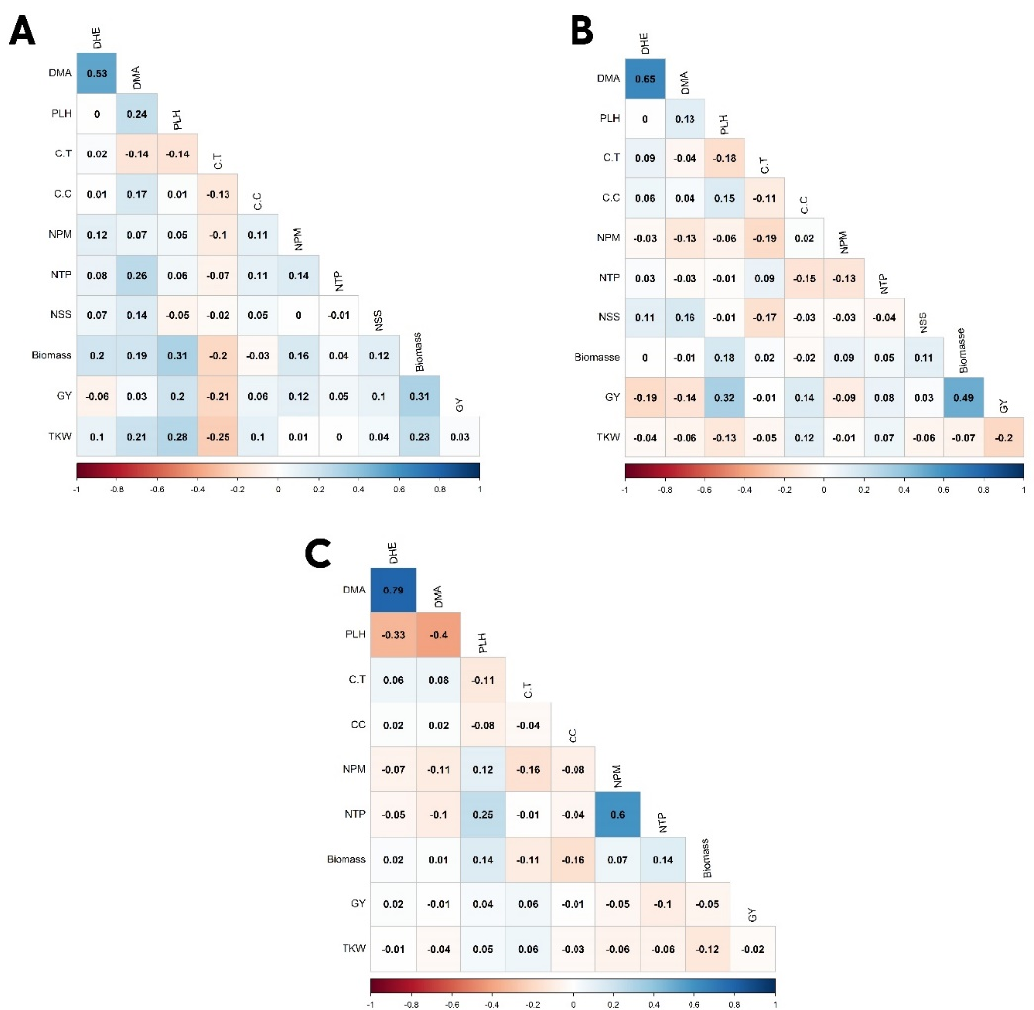
Figure 4. correlation for agronomic and physiology traits under rainfed ( A ) and irrigated ( B ) regime at Sidi Al-Aidi station and rainfed regime at Merchouch station ( C ) in Morocco.